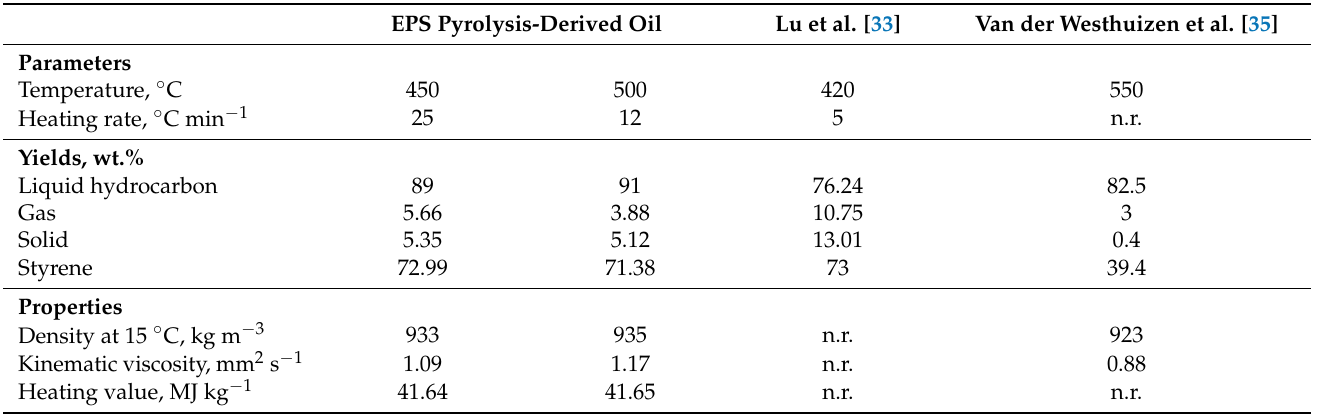
Table 3. Physicochemical properties of liquid hydrocarbon from EPS